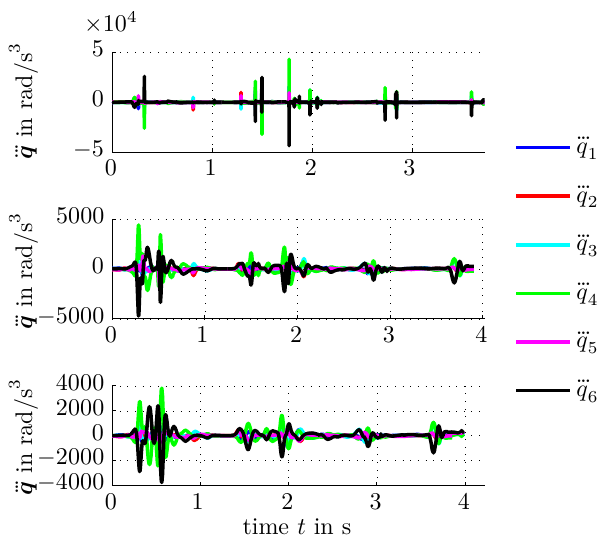
Figure 11. Joint jerks, above: trend of joint jerks for the SDP approach, middle: trend of joint jerks for a smooth solution with ˆ n D = 40 control points for each section, below: trend of joint jerks for a smooth solution with ˆ n D = 25 control points for each section.